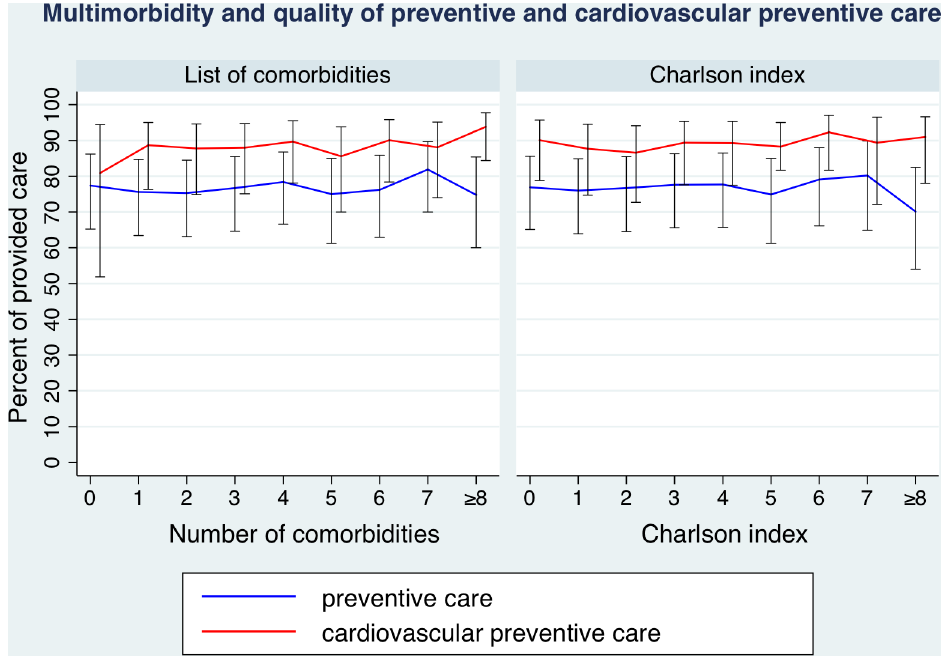
Figure 1. Measures of multimorbidity and association with quality of preventive care. Left part: Number of comorbidities and percent of provided care for preventive care (blue line) and cardiovascular preventive care (red line), bars showing 95% confidence intervals. Right part: Respective analysis with the Charlson index. Data adjusted for age, sex, civil status, legal status, occupation and treatment center. In a second model we adjusted for number outpatient visits and found similar results.